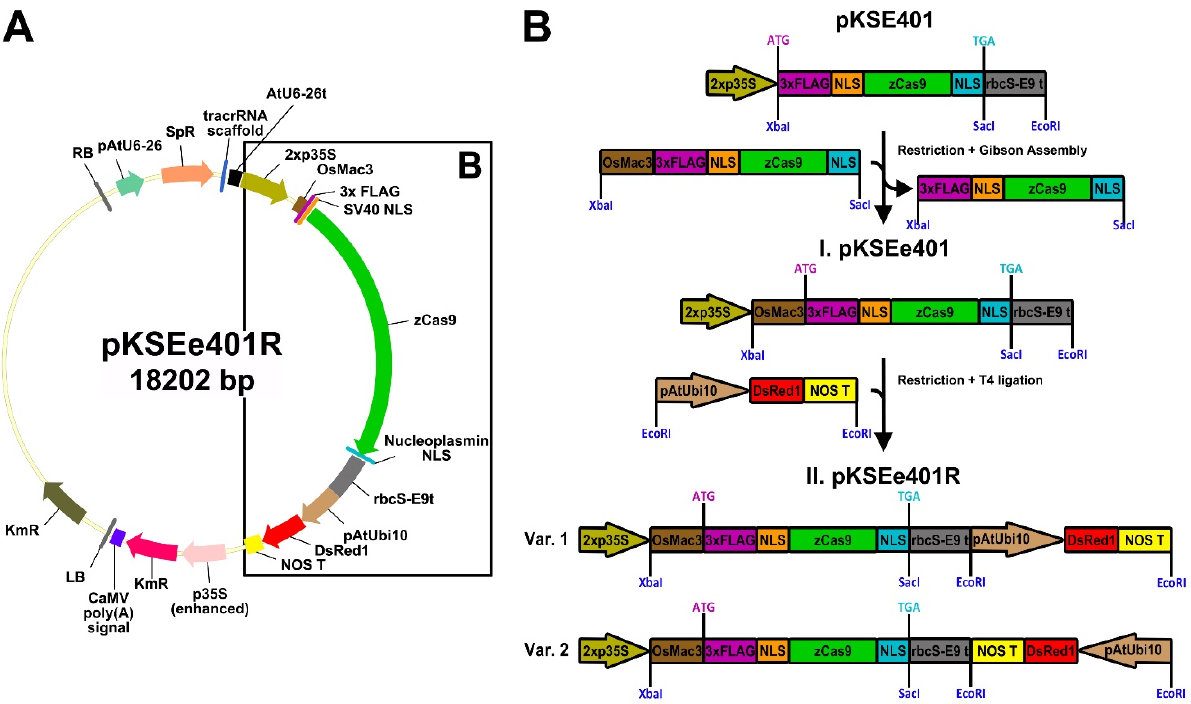
Figure 4. pKSEe401R plasmid. ( A ) Map of pKSEe401R; parts (clockwise): RB—right T-DNA